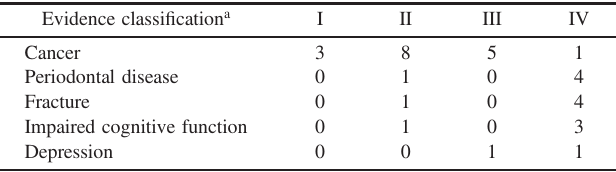
Table 2. Number of studies identi fi ed through literature search Evidence classi fi cation